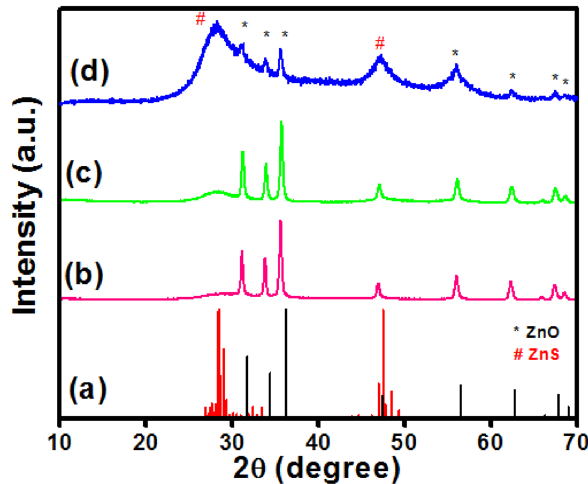
Fig. 1 Powder X-ray diffraction patterns of a standard peaks for ZnO and ZnS, b Z3, c Z4 and d Z5